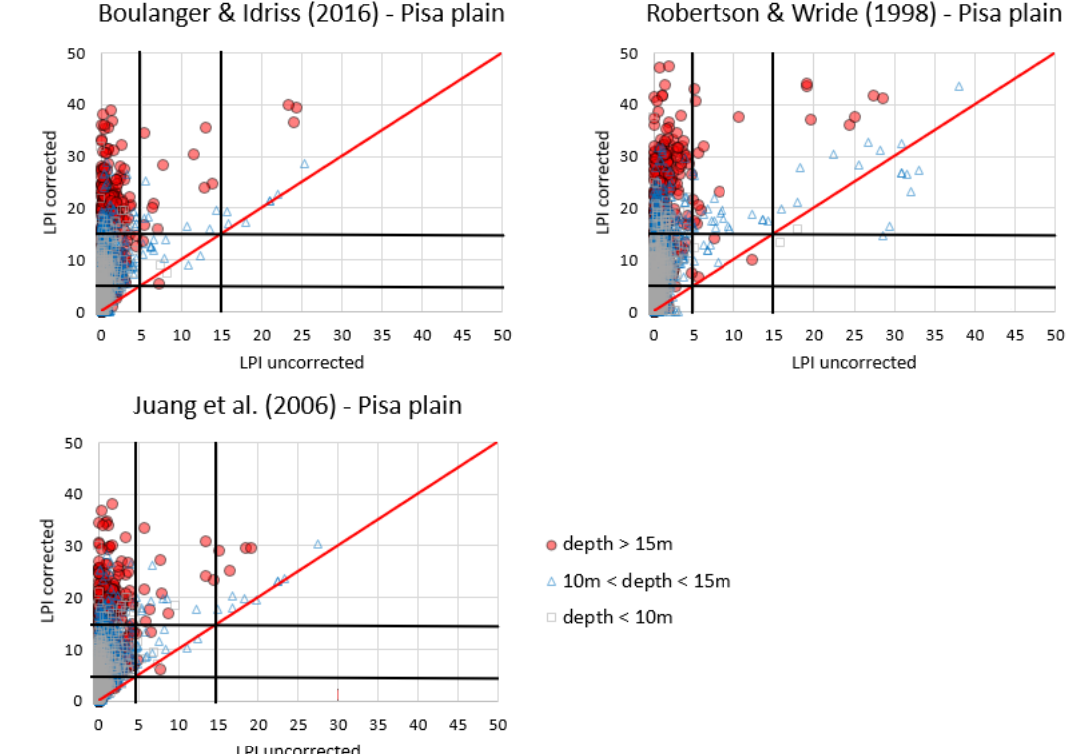
Figure 17. LPI (corrected) vs. LPI (w / o corrections) for the macro-area of the Pisa plain.